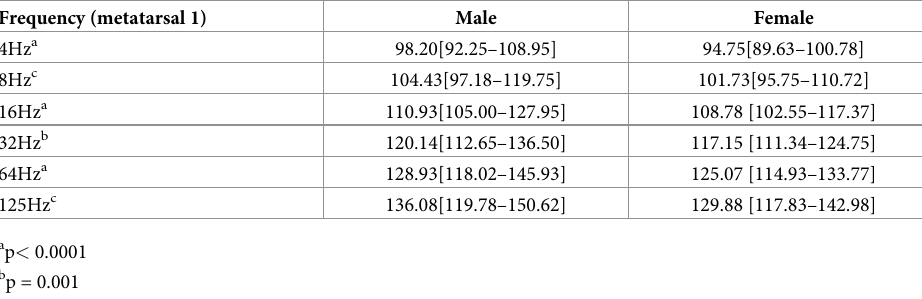
Table 2. VPTs at MTH 1 in male vs. female